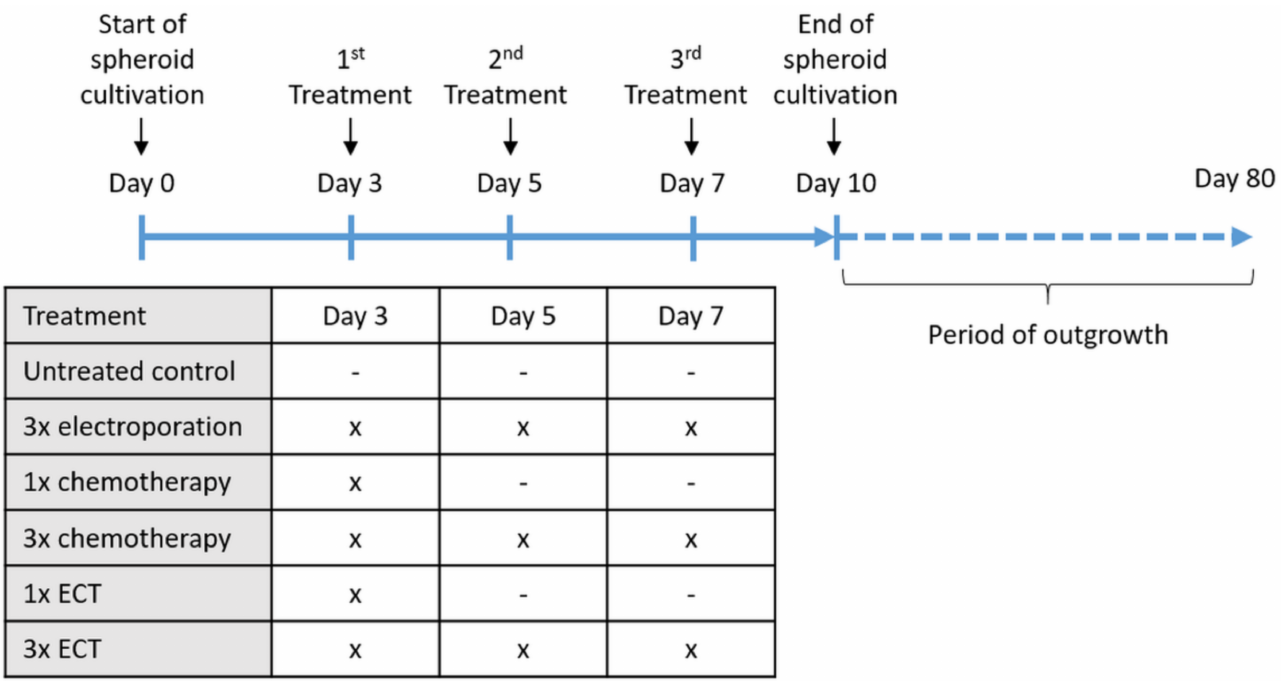
Figure 1. Graphical overview of treatment over time. Abbreviations: ECT =